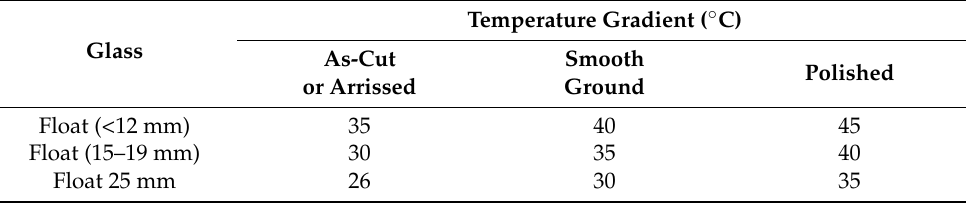
Table 1. Allowable temperature gradients for monolithic float glass, according to prEN thstr:2004 provisions